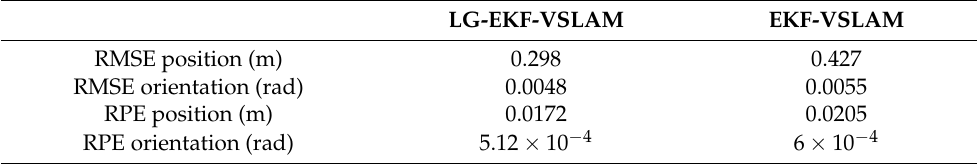
Table 1. Simulation results with known L . Obtained performance estimation for N r = 500